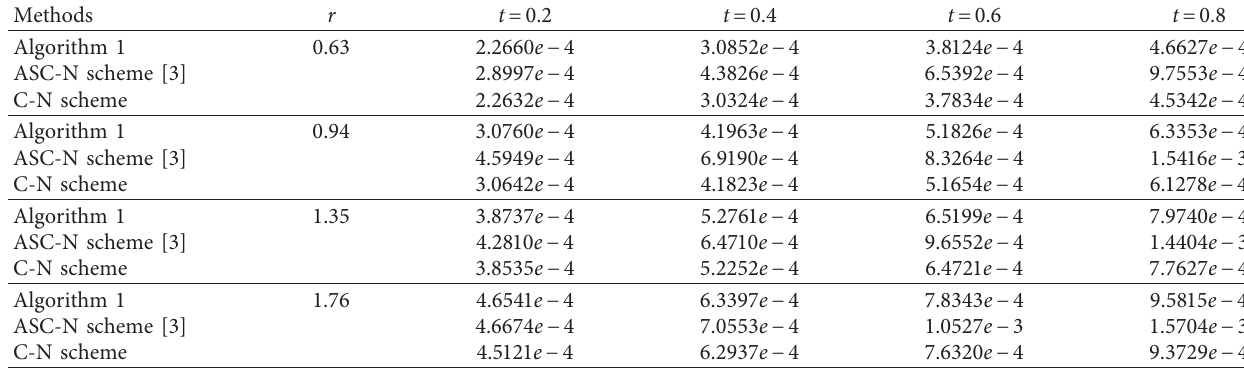
Table 5: Comparisons by the maximum errors to Example 1 for h � 1/25 (i.e., K �